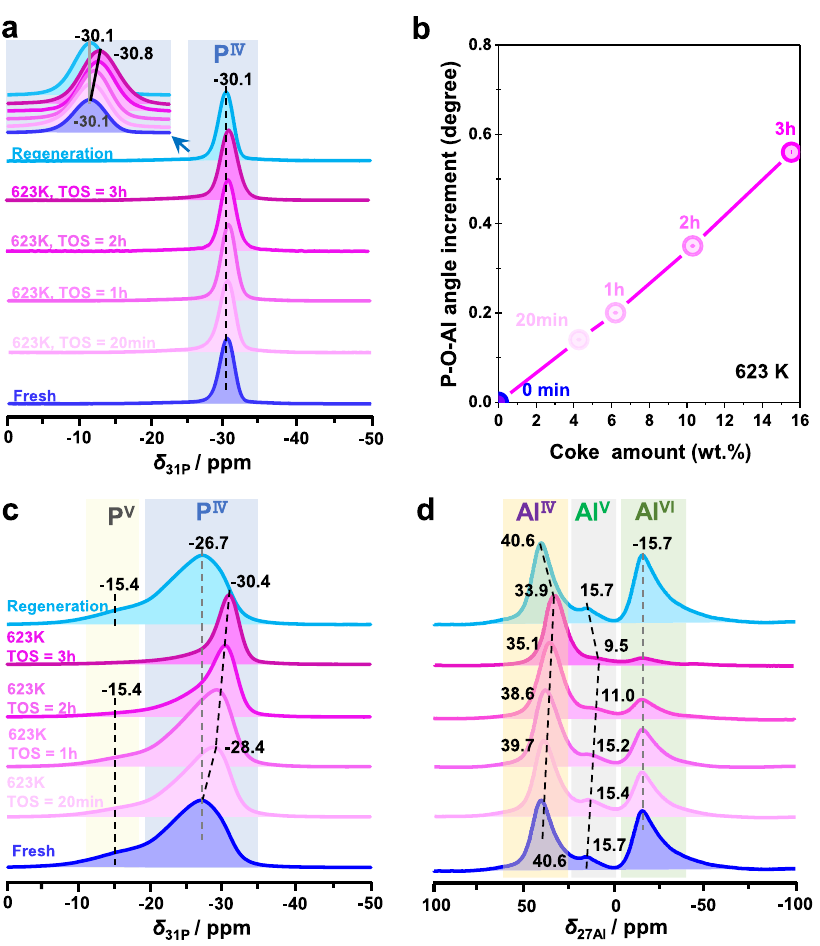
Fig. 3 Probing structural dynamic changes of SAPO-34 catalysts by 1D 27 Al and 31 P MAS NMR spectroscopy. a 31 P MAS NMR spectra and b the increment of the P-O-Al bond angles of fresh and spent SAPO-34 catalysts after the MTO conversion at 623 K for different TOS of 0 – 3 h. c 31 P and d 27 Al MAS NMR spectra of spent SAPO-34 catalysts after the MTO conversion at 623 K for different TOS of 0 – 3 h and subsequent hydration at room temperature for 24